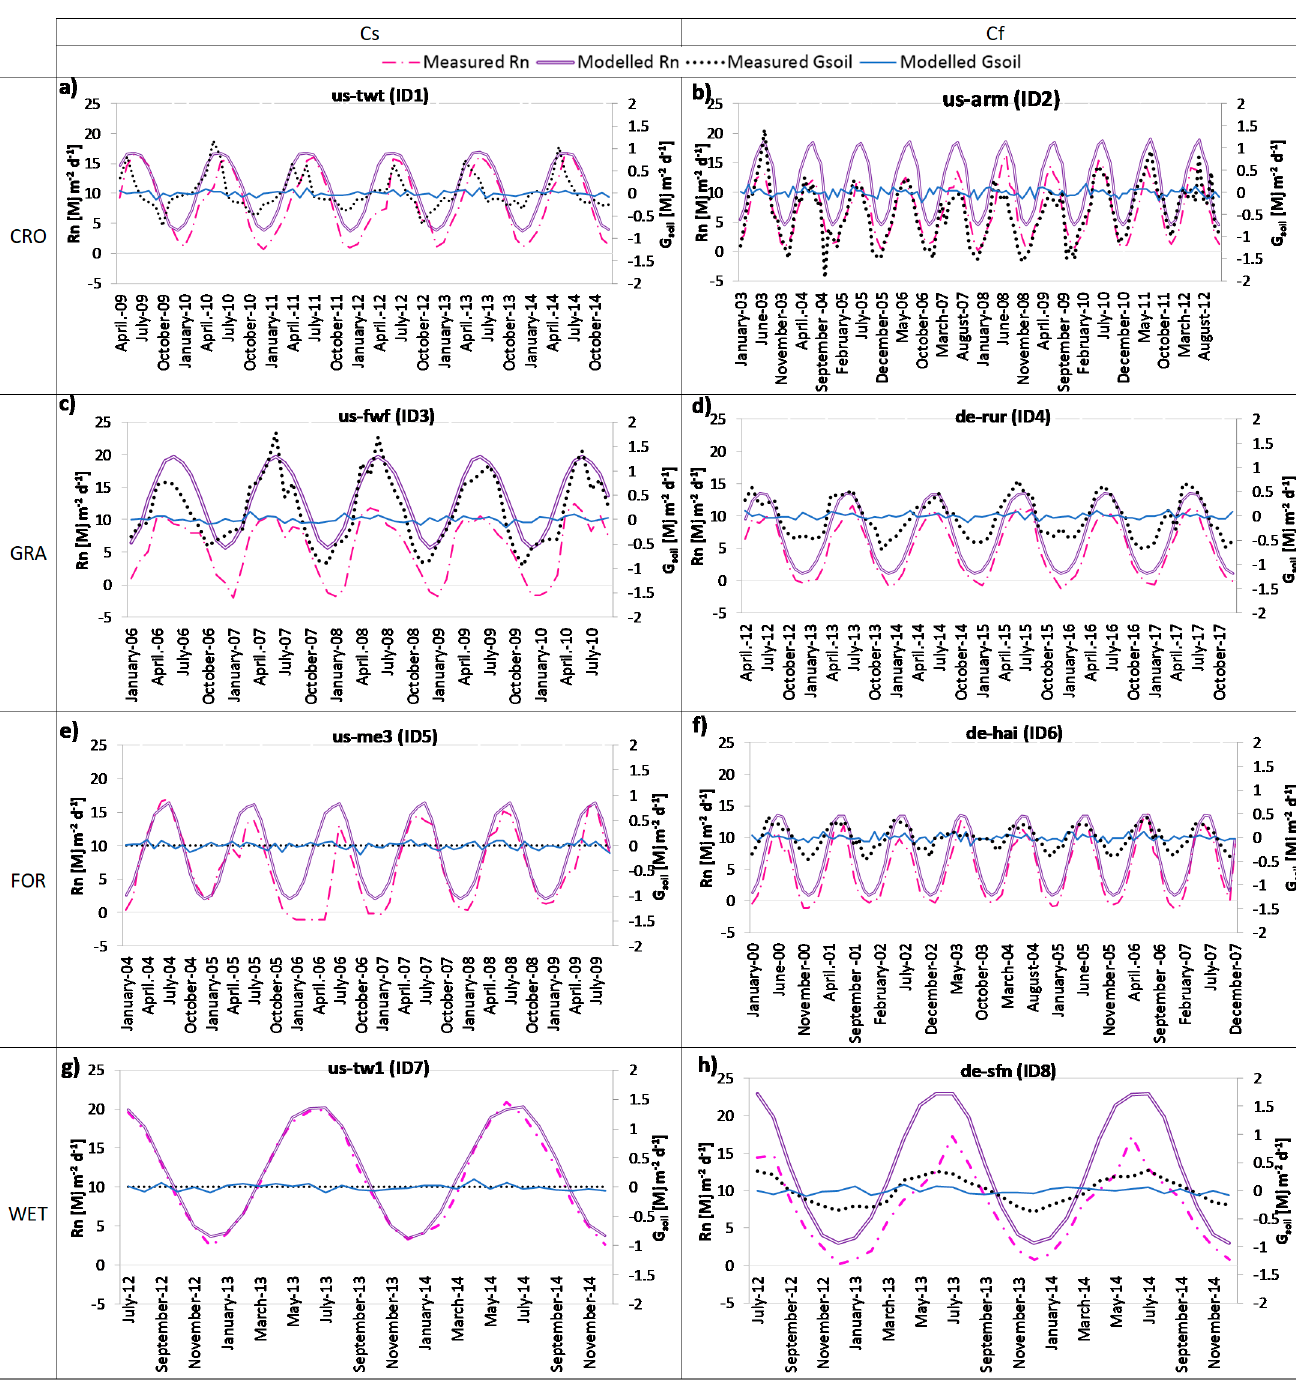
Figure 5. Monthly patterns of observed and modelled Rn and Gsoil for each of the selected site: ( a ) us-twt, ( b ) us-arm, ( c ) us-fwf, ( d ) de-rur, ( e ) us-me3, ( f ) de-hai, ( g ) us-tw1, ( h ) de-sfn.